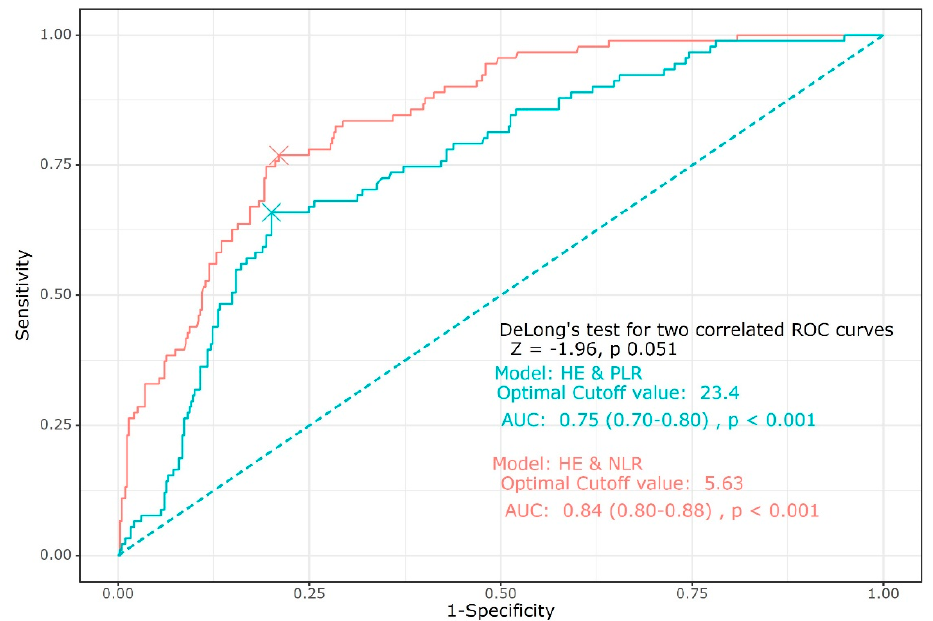
Figure 3. Receiver operating characteristics curves of NLR and PLR for predicting hematoma expansion. Abbreviation: NLR, neutrophil–lymphocyte ratio; PLR, platelet–lymphocyte ratio.